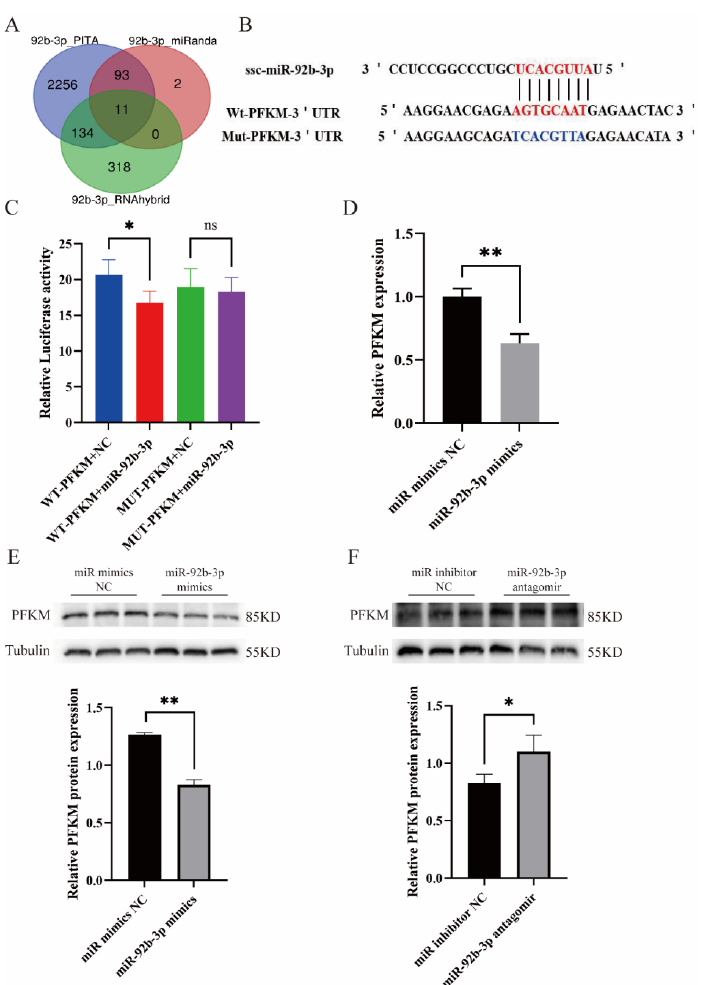
Figure 3. miR-92b-3p targets and regulates the PFKM gene in PTr2. ( A ) The target genes of miR-92b- 3p as predicted by 3 databases. ( B ) Prediction of binding sites and mutation sites of miR-92b-3p to